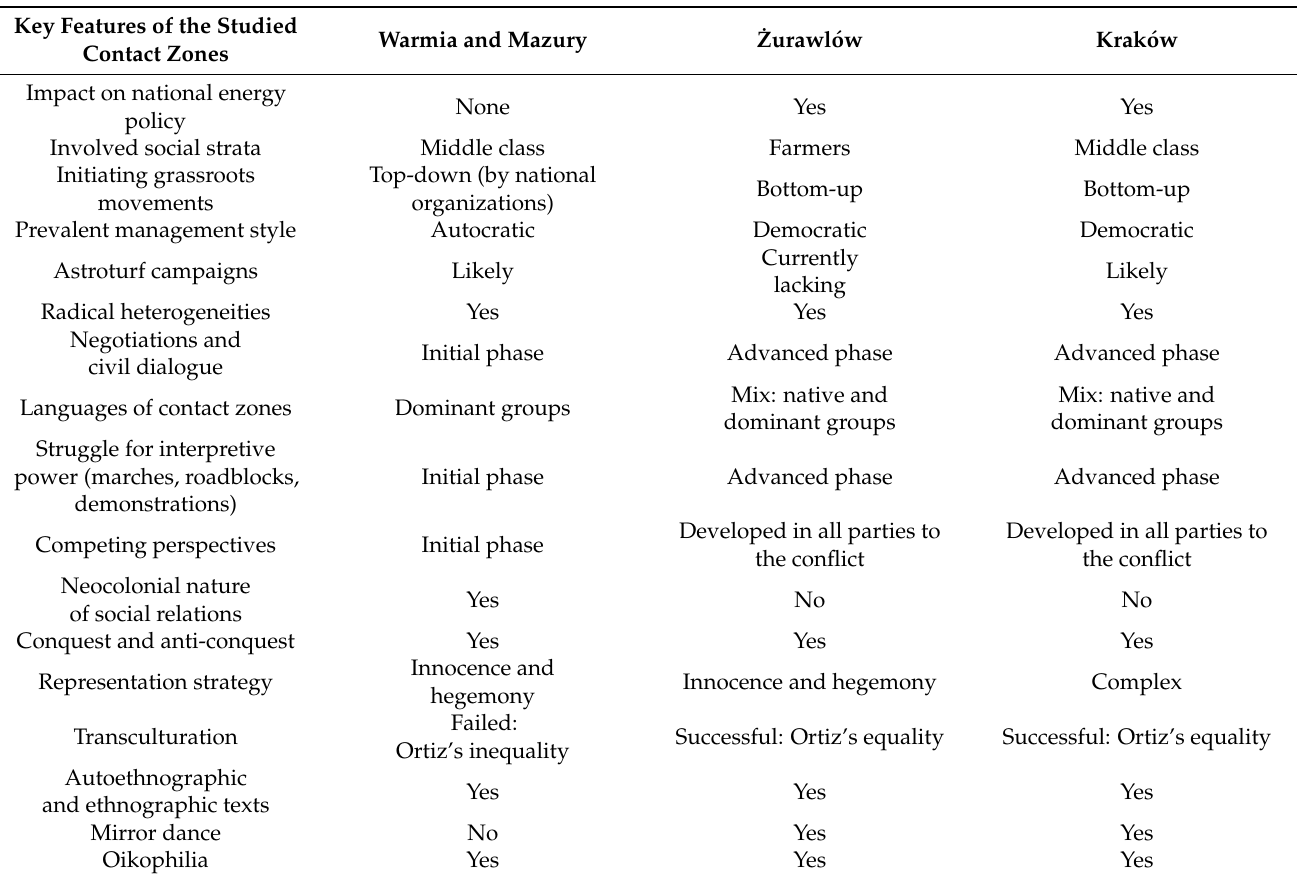
Table 7. Comparison of the most important features of the contact zones in Warmia and Mazury with those of the two reference contact zones in ˙Zurawl ó w and Krak ó